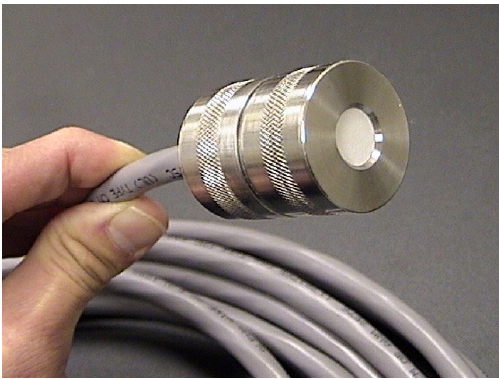
Figure 3. Stainless-steel waterproof package that houses the chemiresistor array. A GORE- TEX ® membrane covers a small window over the chemiresistors.